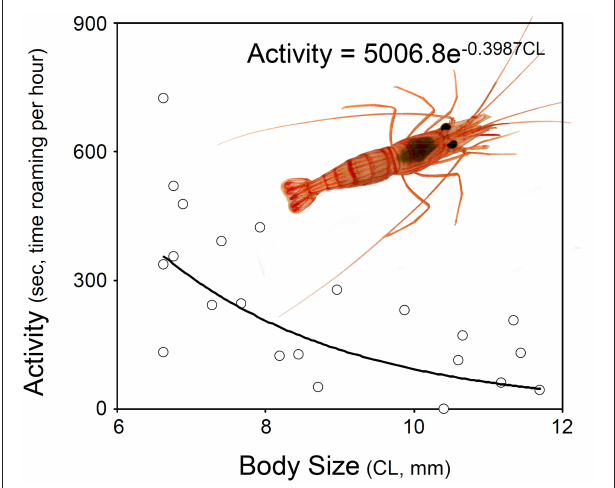
FIGURE 2 | Relationship between activity and body size in hermaphrodites of Lysmata wurdemanni . The best model describing the relationship is exponential (for details see section Materials and Methods and